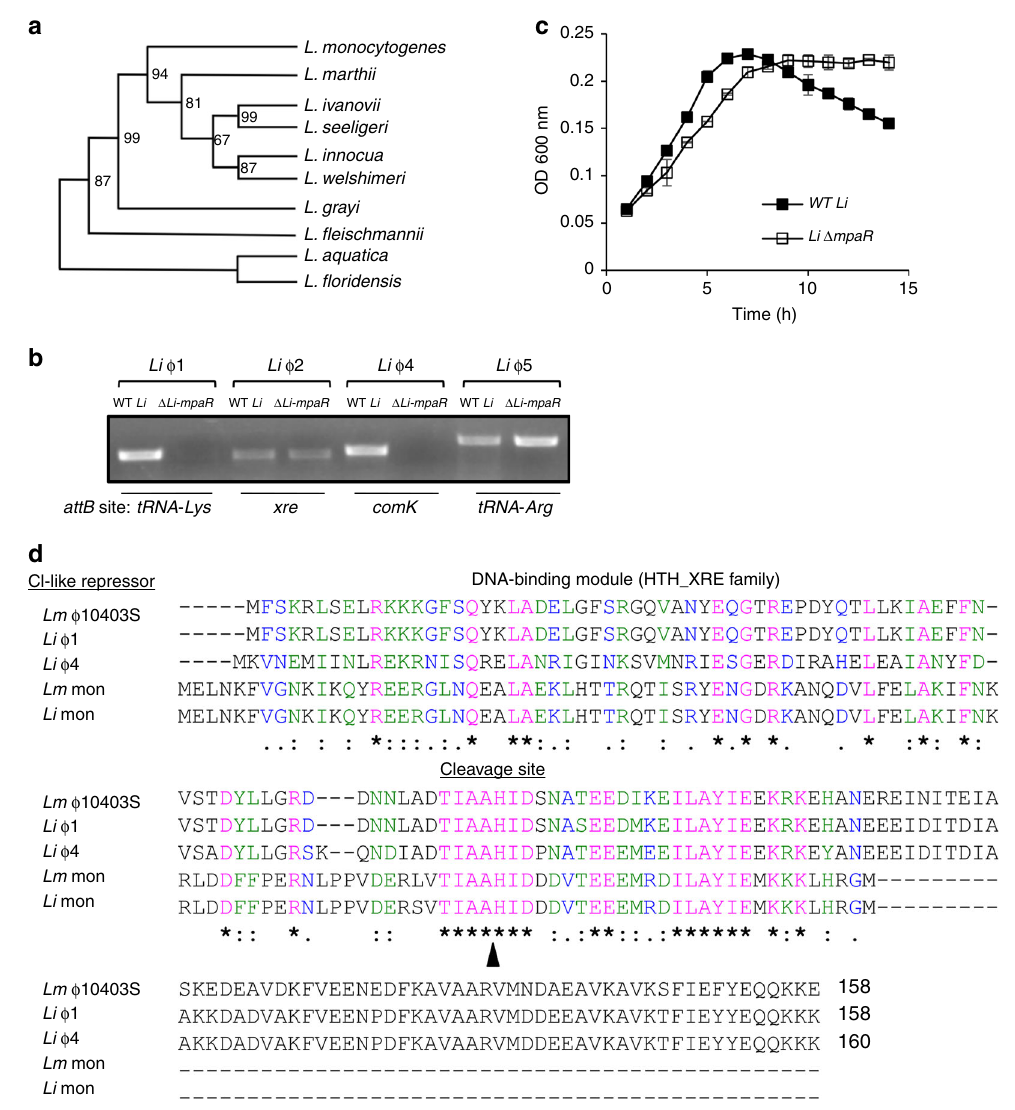
Fig. 7 MpaR functions as a multi-phage coordinator. a Phylogenetic tree of Listeria species based on the amino acid sequence of MpaR (using 12 selected Listeria strains that represent the different Listeria species, as performed by Orsi et al. 2016). Bootstrap values are indicated on the relevant branches. b PCR analysis of the genomic region around the attB sites of L. innocua Clip112624 prophages, performed in wild-type bacteria (WT Li ) and in a strain deleted of the mpaR gene ( Δ Li-mpaR ) under MC treatment. Visible PCR products indicate phage excision and restoration of the attB sites. The genes harboring the prophages attB sites are indicated at the bottom. c Growth analysis of WT L. innocua (WT Li ) and its isogenic mpaR mutant ( Li - Δ mpaR ) with MC (growth without MC is presented in Supplementary Fig. 6). The data shows the mean and the standard deviation of three independent biological repeats. Source data are provided as a Source Data fi le. d Multiple amino acid sequence alignment (by Clustal Omega) of the fi ve different CI-like repressors that were found to be regulated by MpaR in Lm 10403S and L. innocua Clip112624 ( Li ). Identical amino acid residues (aa) are marked with (*), strongly similar aa are marked with (:), and weakly similar aa are marked with (.). The exact cleavage site of MpaR, as obtained by LC-MS/MS analysis of ϕ 10403S CI-like repressor cleavage product, is indicated by a black